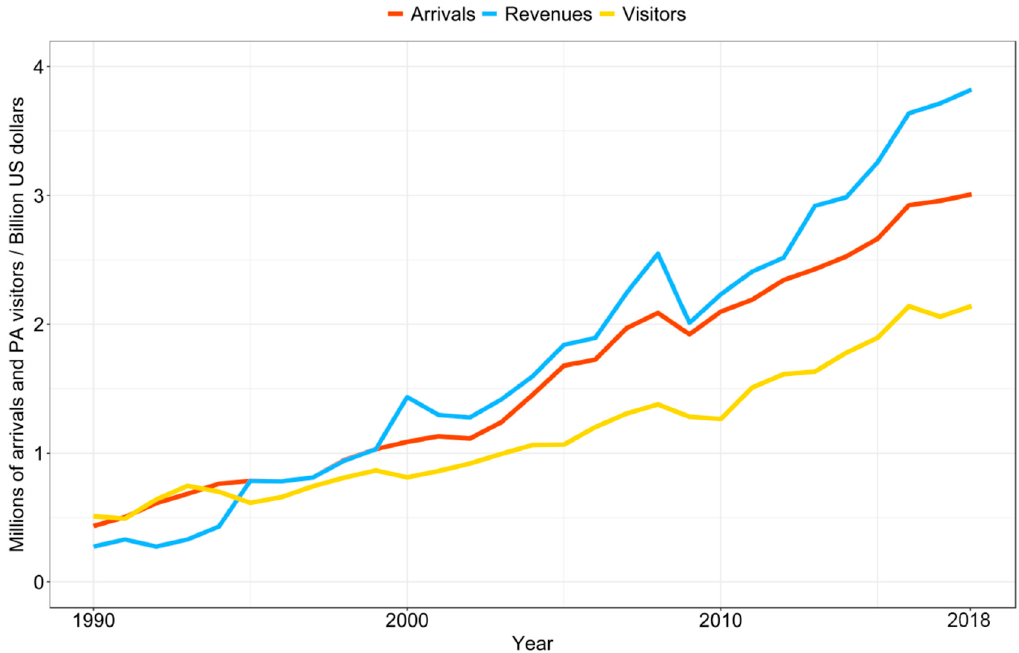
Figure 3. Millions of international arrivals and protected areas, and billions of US dollars revenue from tourism in Costa Rica between 1990 and 2018 [33].